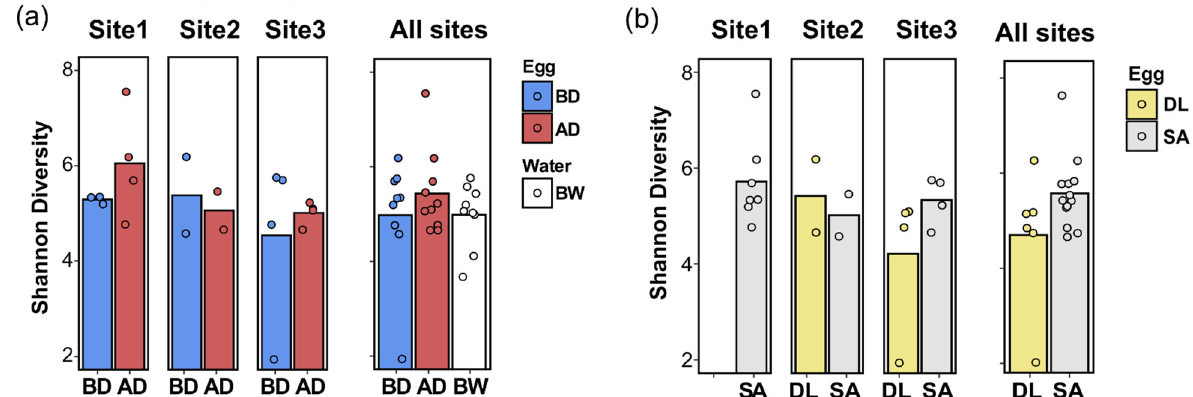
Figure 5. The Shannon index of alpha diversity. The Shannon index is presented according to ( a ) the sample type, including eggs (before disinfection, BD, and after disinfection, AD) and water samples (broodstock water, BW) across the three aquaculture sites (Site 1, Site 2, and Site 3), and ( b ) the species (gilthead seabream, SA, and European seabass, DL) across the three aquaculture sites (Site 1, Site 2, and Site 3), or in the representative plot on the right of each panel, compiling the average Shannon index for all three sites. No significant difference was observed in the Shannon index, by sample type, species, or site.